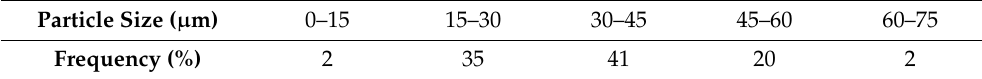
Table 2. Particle size distribution of the as-received atomized AA7075 powders.